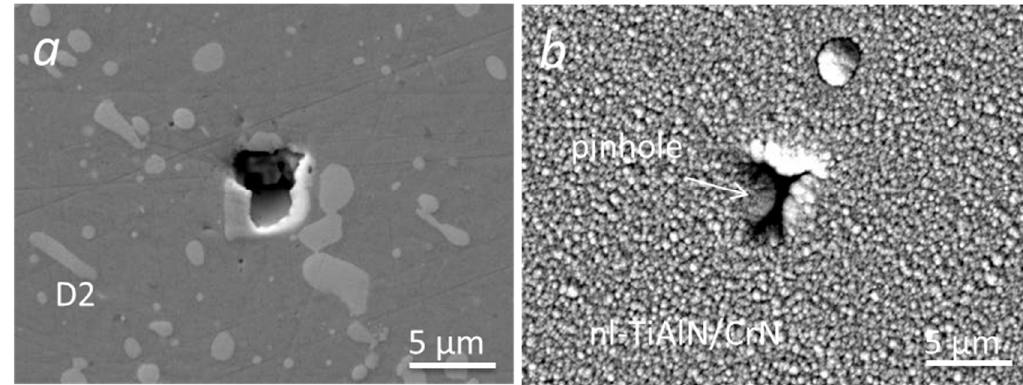
Figure 4. Pit on D2 tool steel substrate surface at the site where a carbide grain was torn out from the surface during the polishing ( a ) and the same substrate surface area after deposition of nl-TiAlN/CrN nanolayer ( b ) [46]. Close to the pinhole a nodular defect was also formed.